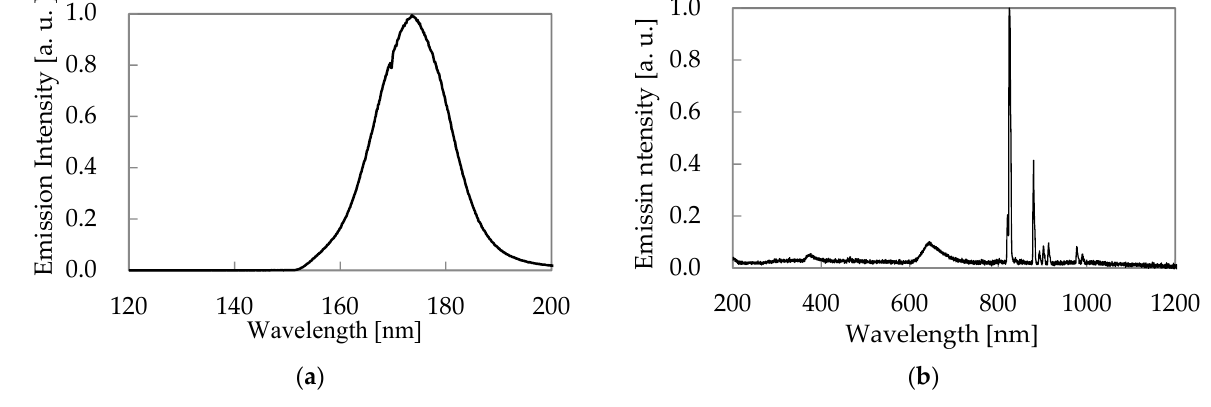
Figure 6. The emission spectra of the excimer lamp: ( a ) VUV region; ( b ) UV–IR region. VUV light emission is generated by the following process in Equations (3)–(5) [50]. The Xenon atom was excited by the electrons in plasma. The excited xenon atom and ground state xenon atoms generated the xenon excimer (Xe ∗ ) by a three-body reaction. The light emission of 172 nm occurred by dissociation of the xenon excimer to the xenon atoms. Figure 6b shows the UV–IR emission spectra. Light emissions of 823 nm, 828 nm, 882 nm, 985 nm, 905 nm, 916 nm, 980 nm and 992 nm by 6p – 6s transition of xenon atoms were observed [51].